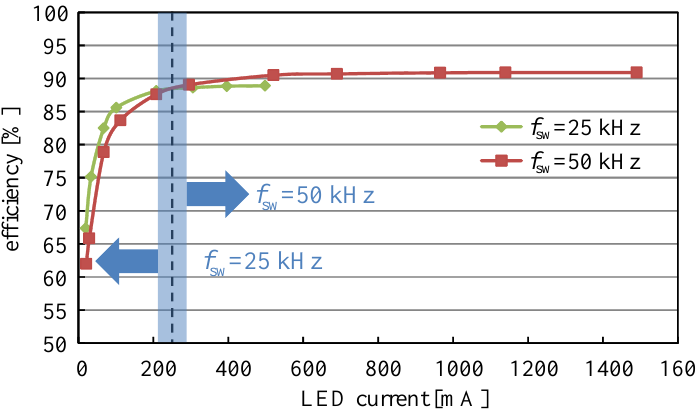
Figure 31. Experimental results of the efficiency with the switching frequency as 25 kHz and 50